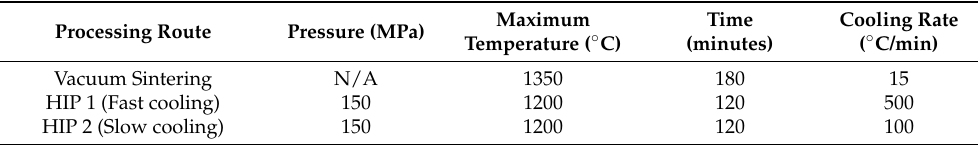
Table 1. Parameters selected according to Ti35Nb2Sn processing